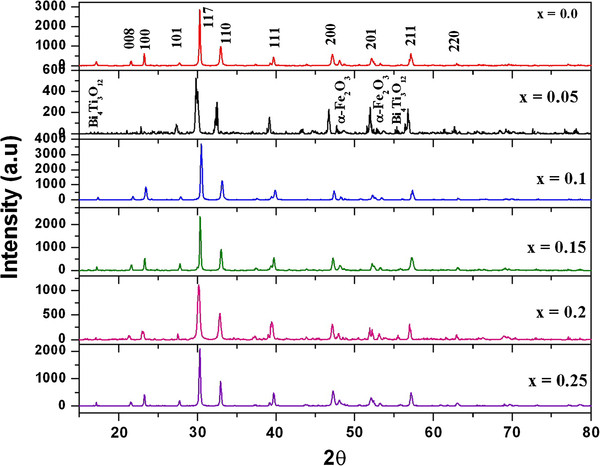
XRD pattern for Bi4 −xNdxTi3FeO12(0.0 ≤ × ≤ 0.25, × = 0.05) nanoparticles.